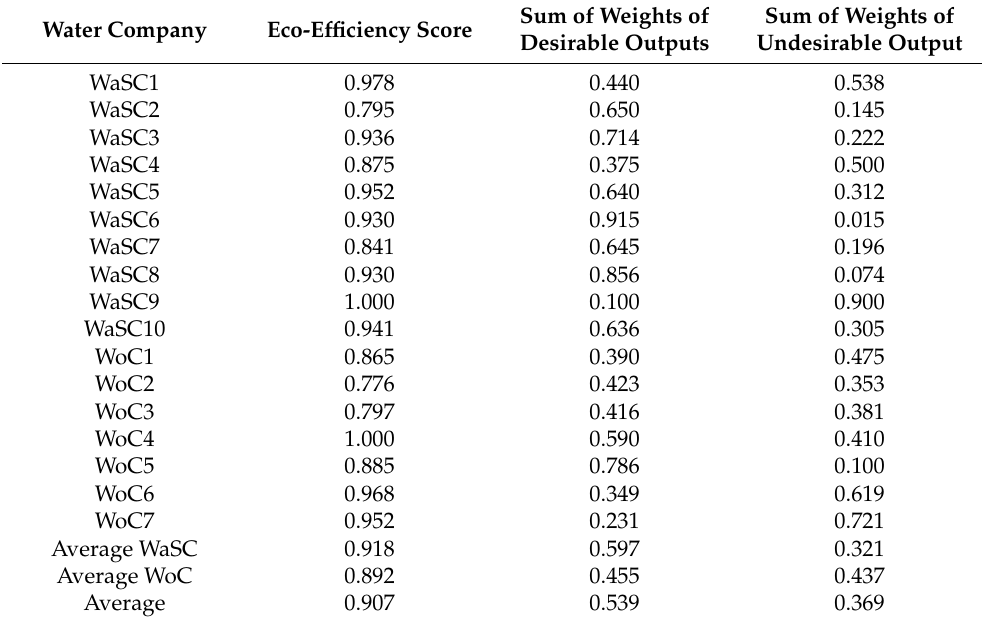
Table 3. Eco-efficiency of water companies estimated using Model